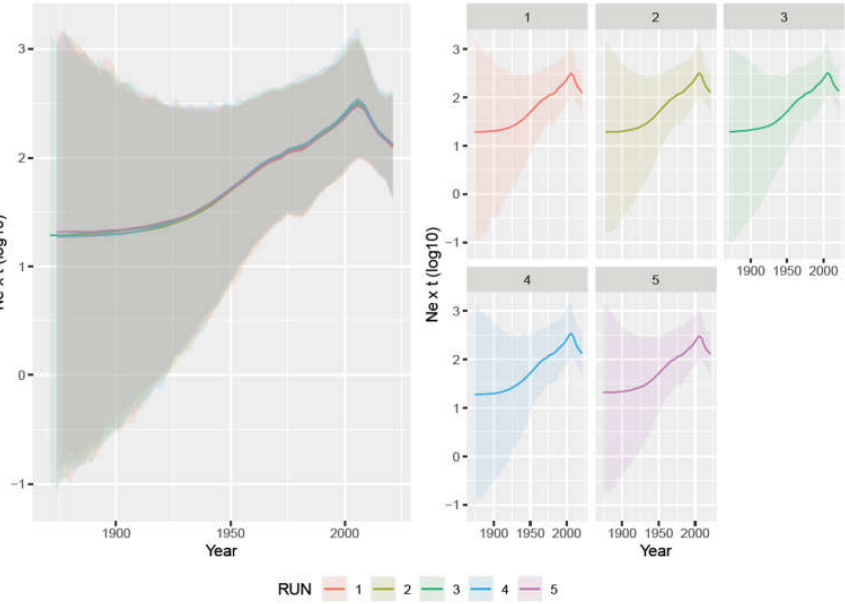
Figure 1. Left figure: mean relative genetic diversity (Ne × t) of the worldwide PPV1 population over time. The results of the five independent runs have been color-coded. Right figure: mean and upper and lower 95HPD values are reported for each run.